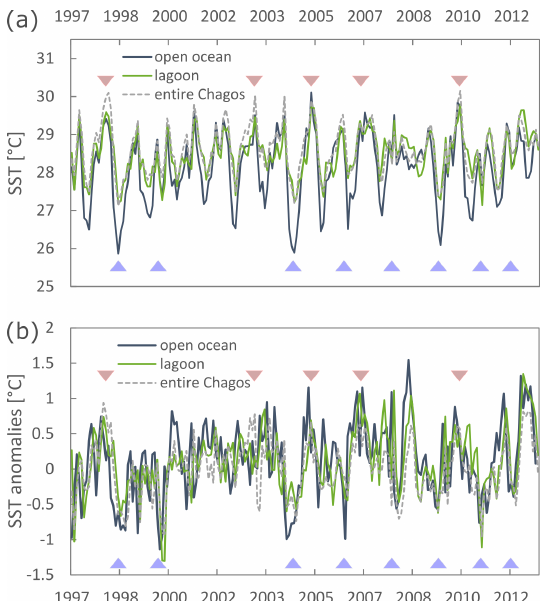
Figure 3. Satellite SSTs for different settings (lagoon: green; open ocean: dark blue) and the entire Chagos Archipelago (gray; aver- aged over the region from 4 to 8 ◦ S and from 70 to 74 ◦ E). (a) Monthly satellite SST means and (b) satellite SST anomalies. For the open-ocean and lagoon setting we used the high-resolution satel- lite SST product AVHRR (Casey et al., 2010), and for the en- tire Chagos Archipelago we used NOAA “Reynolds” OI v2 SST (Reynolds et al., 2002). Triangles indicate El Niño (red) and La Niña events (blue) based on Brönnimann et al. (2007) and the oceanic Niño index ONI (available at: https://www.ggweather.com/ enso/oni.htm, last access: 18 October 2018; El Niño and La Niña Years and Intensities,